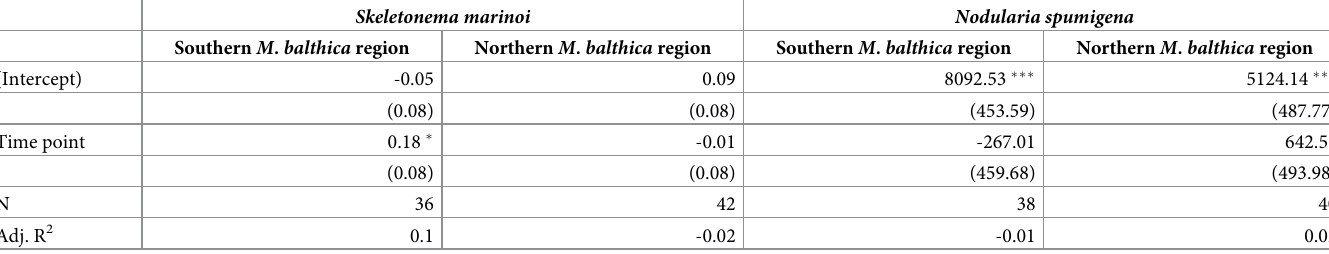
Table 2. Multiple linear regression of phytoplankton detection in Macoma balthica by qPCR over time.